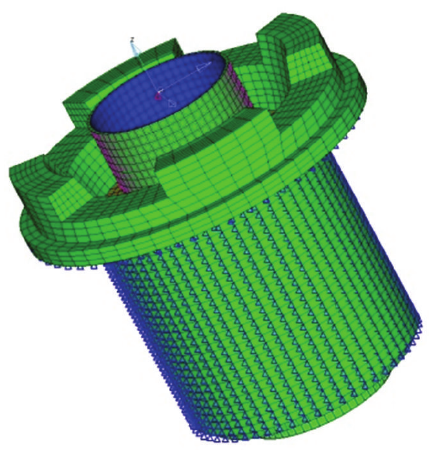
Figure 3: FE model of rubber bushing.